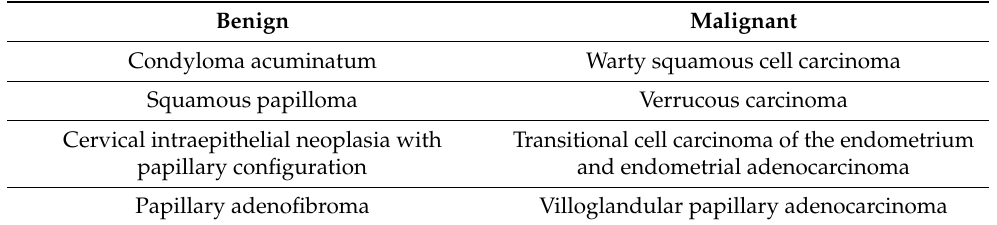
Table 1. Differential diagnosis of papillary lesions of the cervix